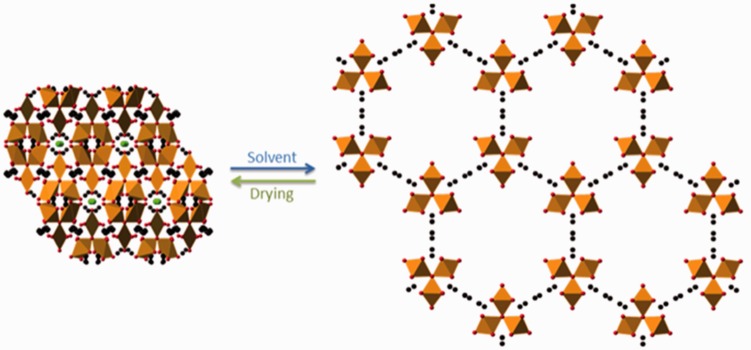
Predicted 3D structure of hydrated and dehydrated MIL-89. Images were obtained using CrystalMaker software 9.2 and data from Serre et al.27 The structures are “viewed” down the z-axis. The orange polyhedra represents iron atoms while red, black, and green spheres represent oxygen, carbon, and chlorine atoms, respectively.